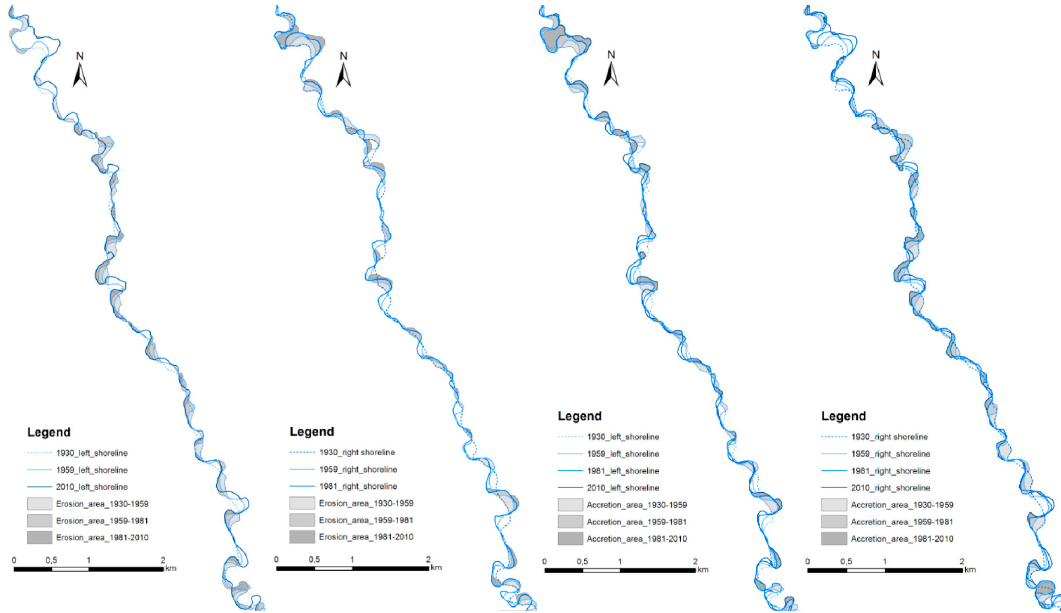
Figure 3. Bank erosion and accretion between 1930 and 2010.